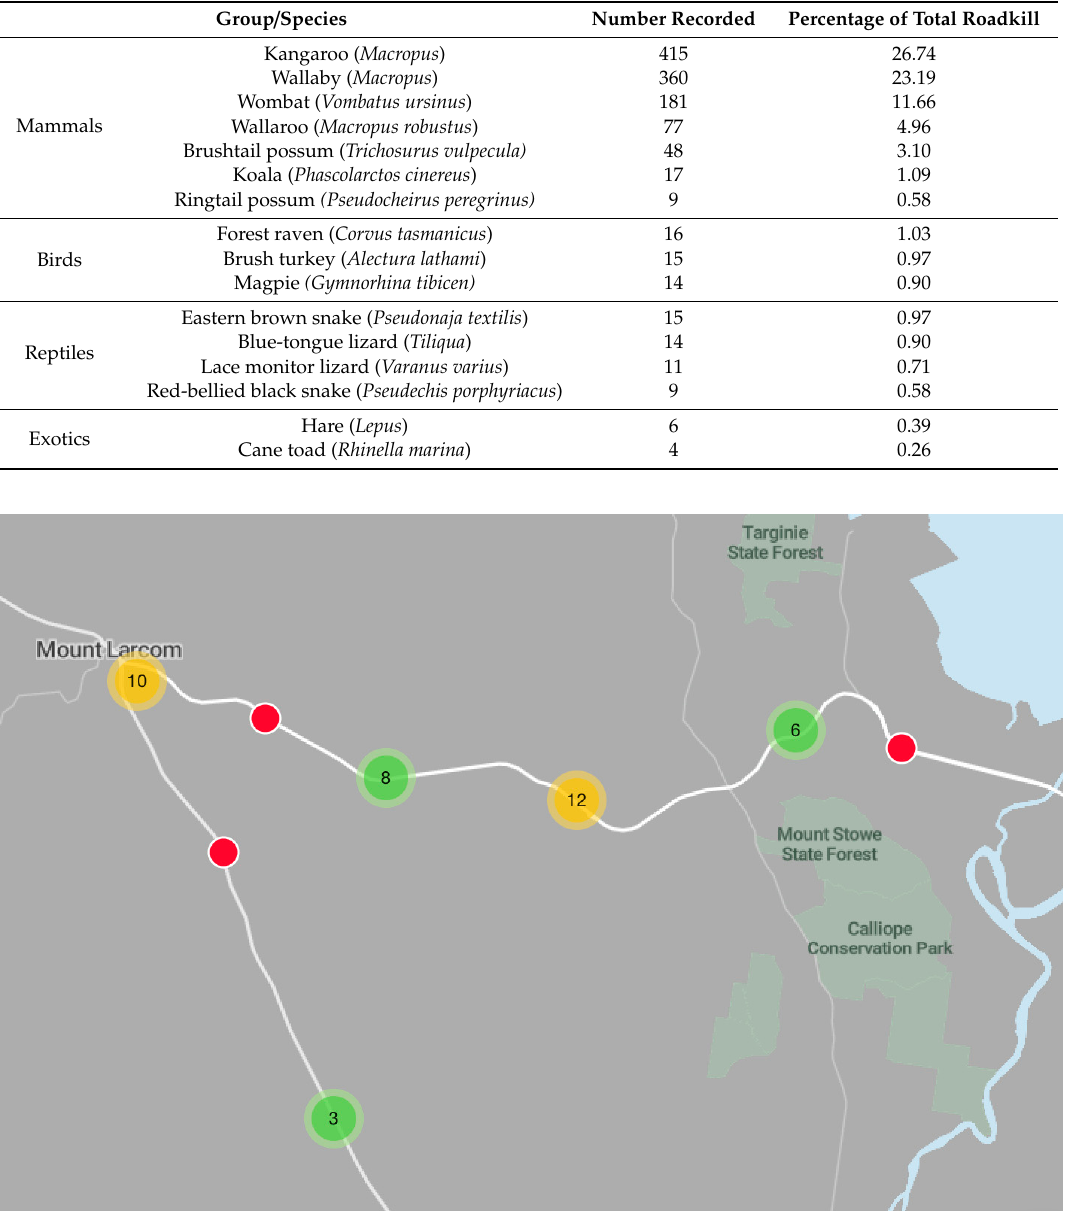
and the yellow dots represent upwards of ten